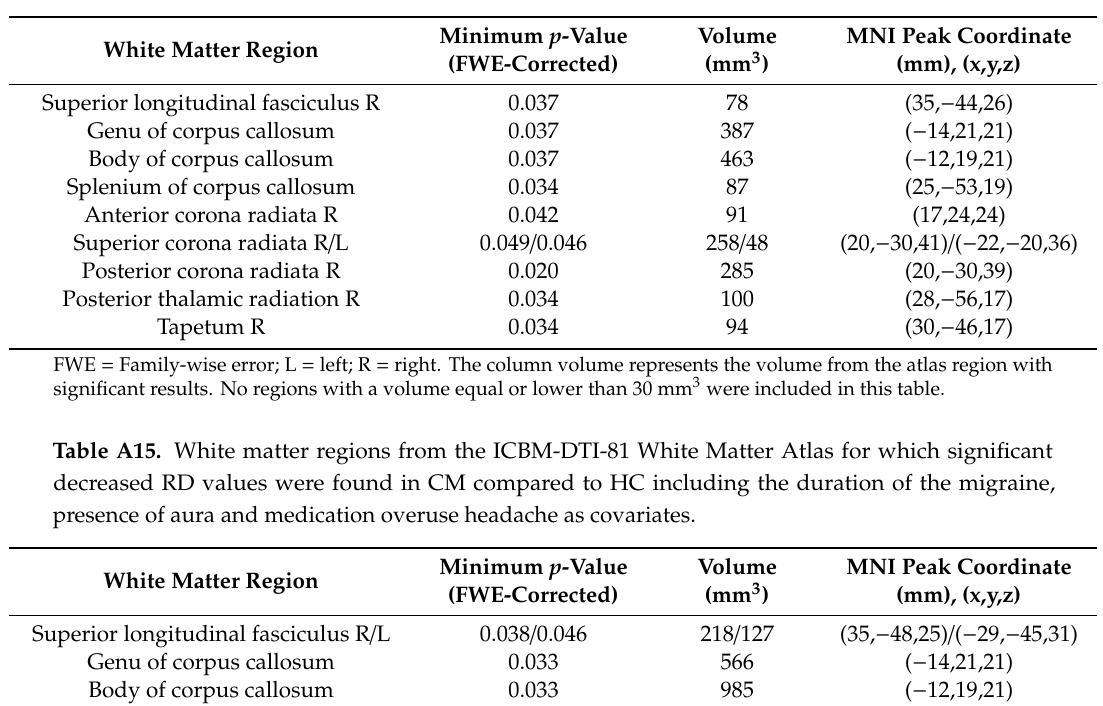
Table A14. White matter regions from the ICBM-DTI-81 White Matter Atlas for which significant increased FA values were found in CM compared to HC including the duration of the migraine, presence of aura and medication overuse headache as covariates.